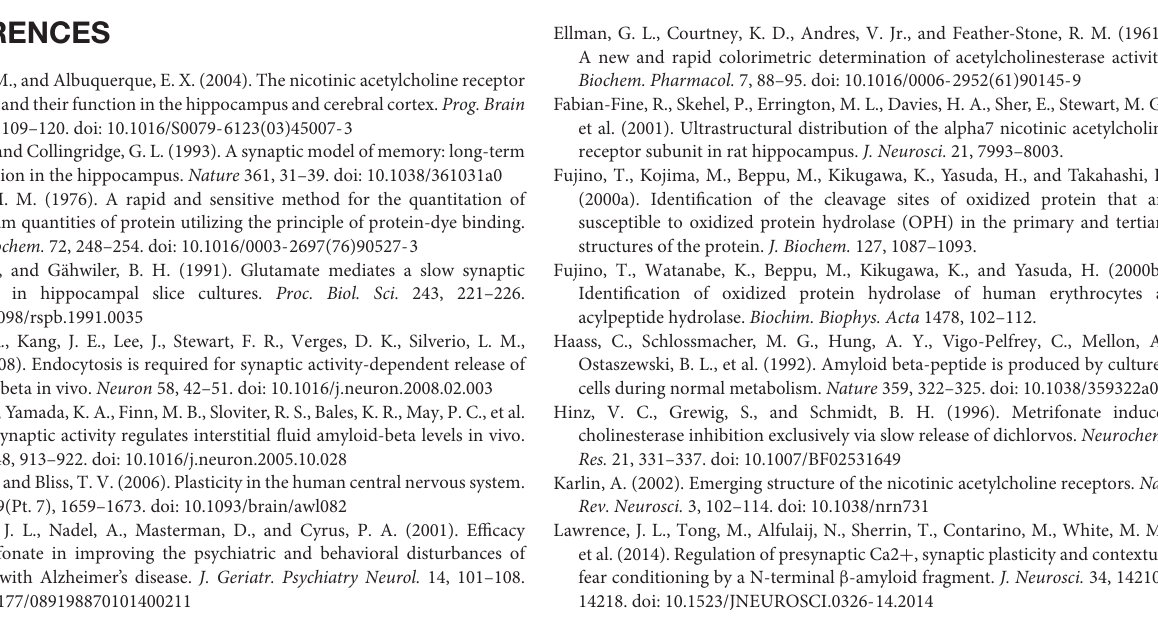
FIGURE S1 | Differential effects of low and high DDVP doses on spatial memory measurements (A–D) Effect of treatment with 0.1 mg/kg DDVP (black columns) on latency to escape (A) , distance to platform (B) , time in platform (C) , and distance in platform (D) . As it can be observed, treated rats spent more time in platform respect to control group (C, D) . (E–H) Effect of treatment with 2.0 mg/kg DDVP (black columns) on latency to escape (E) , distance to platform (F) , time in platform (G) , and distance in platform (H) . Only the parameter “distance to platform” resulted to be significantly decreased in DDVP treated rats respect to control group (F) . ∗ p < 0.05, unpaired t